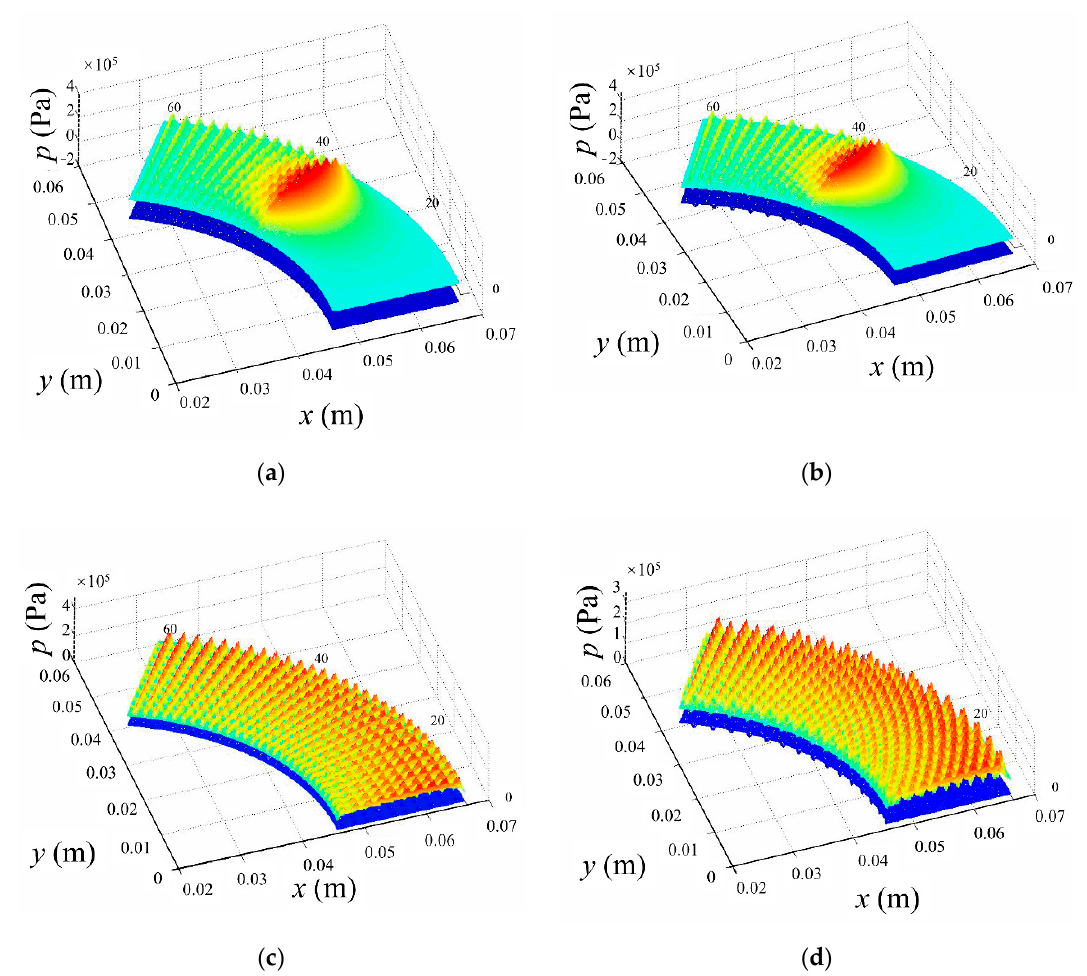
Figure 3. The pressure distribution of four typical texture distribution arrangements: ( a ) A—partial radiation array; ( b ) B—partial staggered radiation array; ( c ) C—full radiation array and ( d ) D—full staggered radiation array.